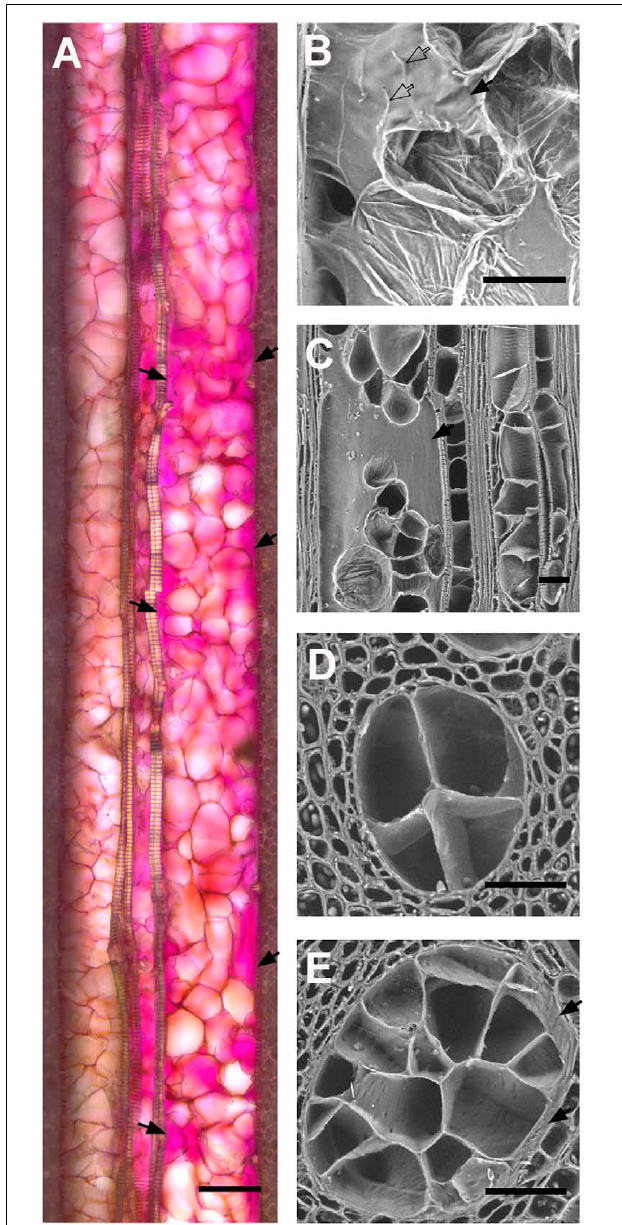
FIGURE 5 | Effect of vessel diameter on the quality of vessel occlusion with tyloses in four V. vinifera L. cultivars. (A) Micrograph of longitudinal section of occluded vessels found in Phaeomoniella chlamydospora inoculated grape cv Cabernet Sauvignon (bright field, ruthenium red). Note the difference in the diameter of the vessel on the left side (about 90 µ m of diameter) and the vessel on the right side (about 150 µ m of diameter). Note the compact network of tyloses that walls off the narrowest vessel while large pockets of gels (solid black arrows) are present in the wider vessel. (B,C) Scanning electron micrograph of a longitudinal section of P. chlamydospora infected grapevine cv Thompson Seedless. Note the presence of a large pocket of gels observed in occluded vessel. (D,E) Scanning electron micrographs of occluded vessels of various diameters as observed in the stem of grapevine cv Thompson Seedless infected with P. chlamydospora . Note the increasing number of tyloses occluding cross-sectional area of vessels with the increase of vessel diameter. (A,B) Scale bar = 100 µ m. (C–E) Scale bar = 50 µ m.